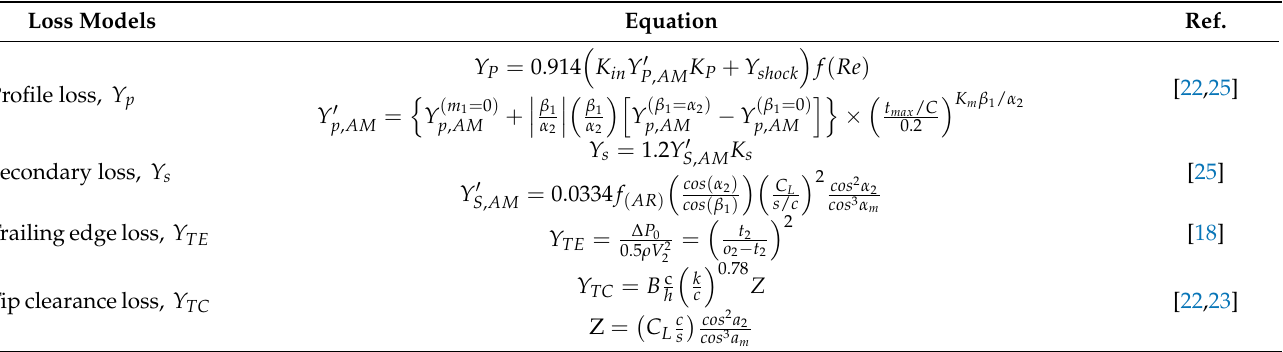
Table 3. Equations of loss coefficient (profile, secondary, trailing edge and tip